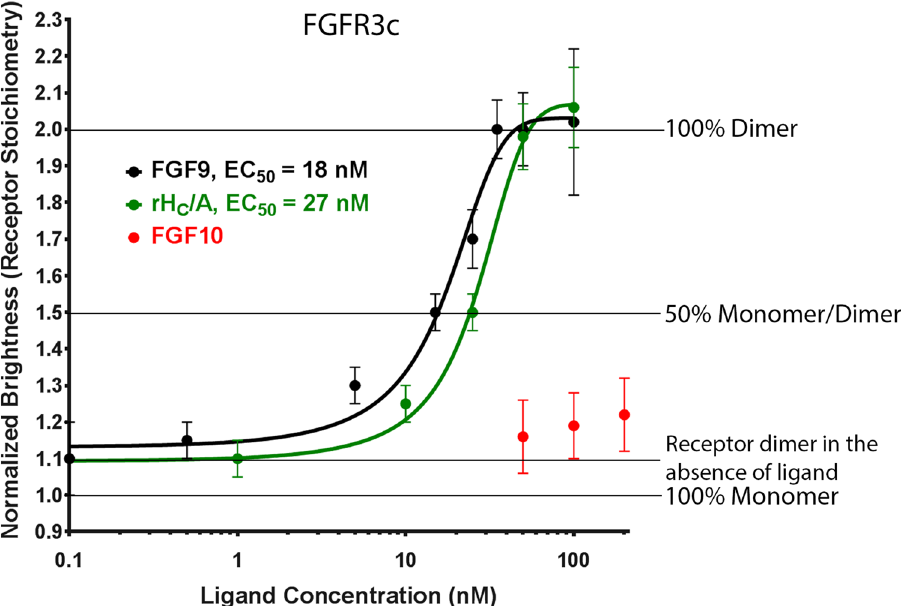
Figure 3. rH C /A induces FGFR3c dimerization. Native ligand FGF9 (black) (EC 50 = 18 nM [95% CI; 13, 24]) and BoNT/A binding domain (rH C /A) (green) (EC 50 = 27 nM [95% CI; 18, 41]), but not FGF10 (red), dimerize fluorescently tagged FGFR3c in transfected PC-12 cells. Points represent the average normalized brightness values ± SD from greater than 30 cells collected on 4 independent days.